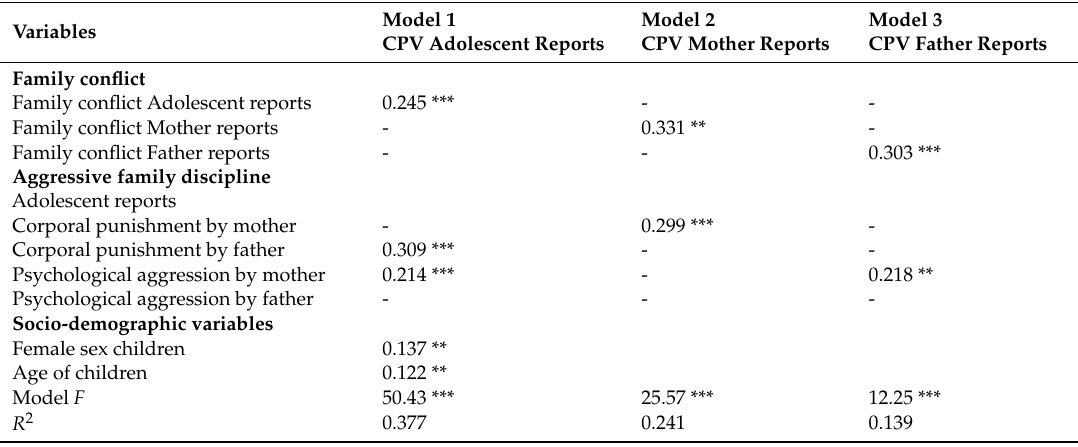
Table 3. Multiple regression models for child-to-parent violence depending on